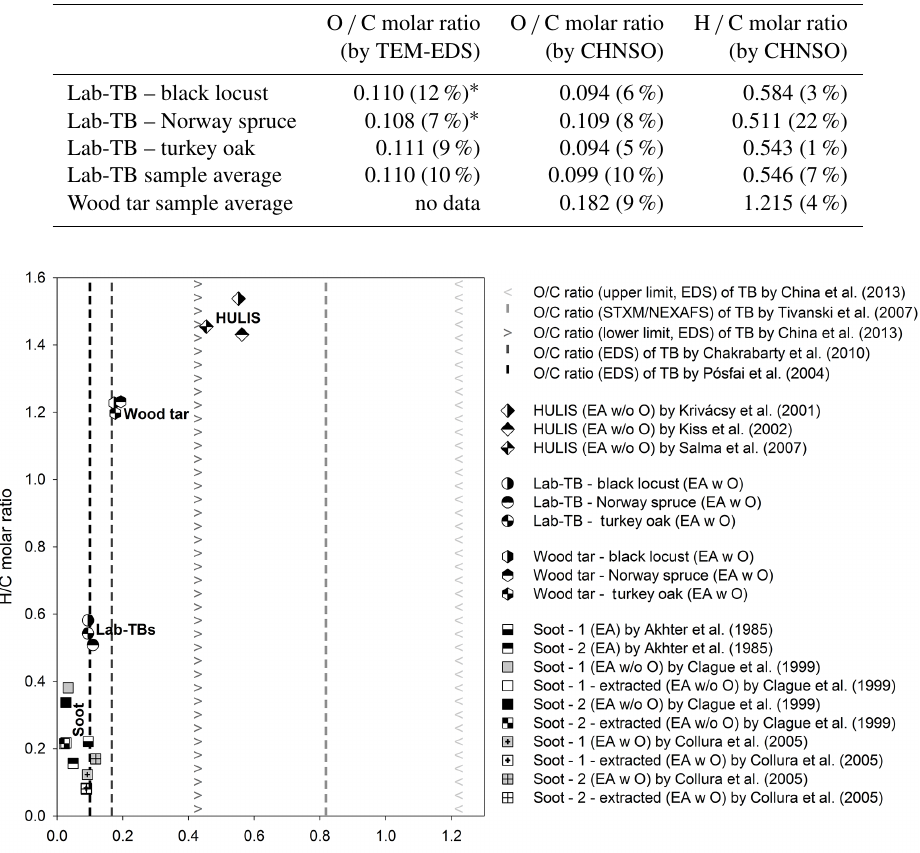
Table 1. Oxygen to carbon (O / C) and hydrogen to carbon (H / C) molar ratios of laboratory-generated TBs and wood tar samples measured by TEM-EDS (from analysis of 12 particles from each sample) and by CHNSO elemental analyser. The numbers in parentheses represent the relative standard deviation (RSD%) of the parameters. ∗ Data from Hoffer et al. (2017).